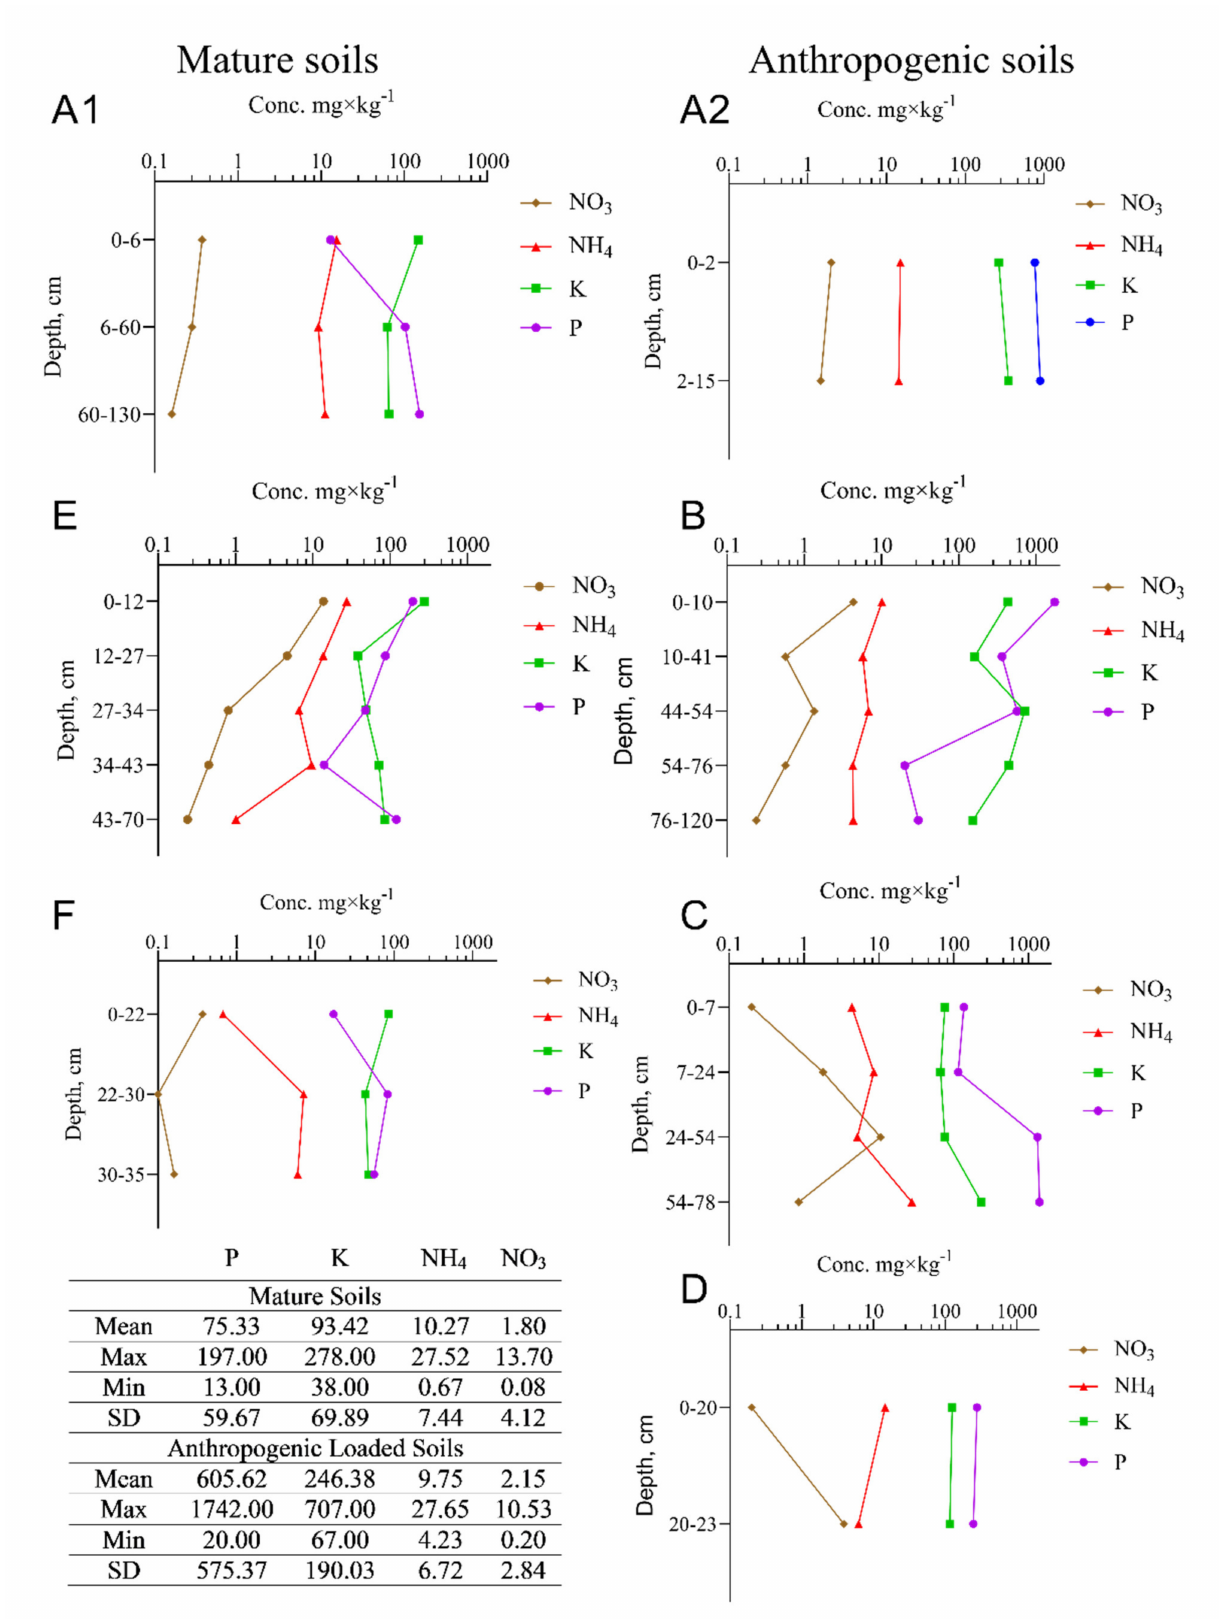
Figure 3. Distribution of nutrients in soil profiles and basic statistics: ( A1 , E , F )—mature soils; ( A2 , B , C , D )—anthropogenic loaded